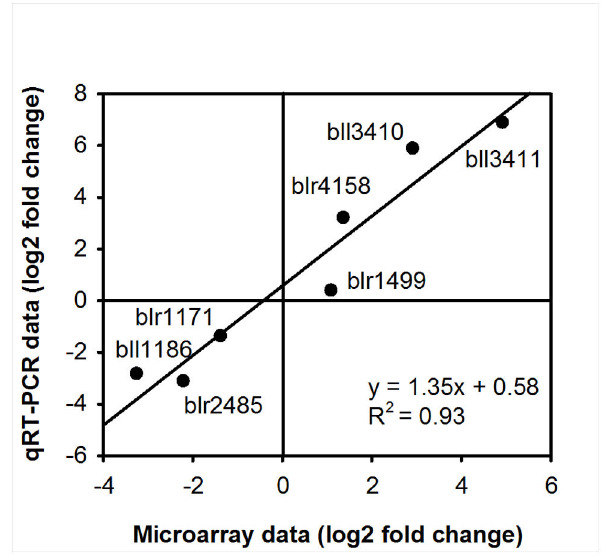
Figure 4. Comparison of log and microarray data.